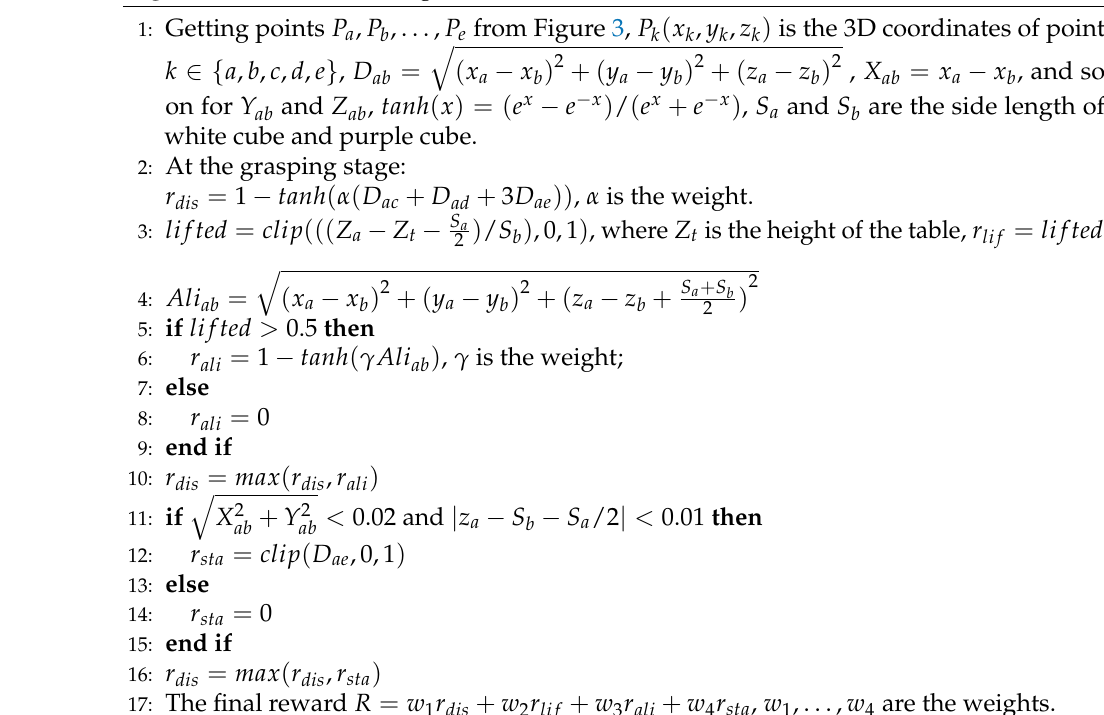
Algorithm 3 Reward setting.